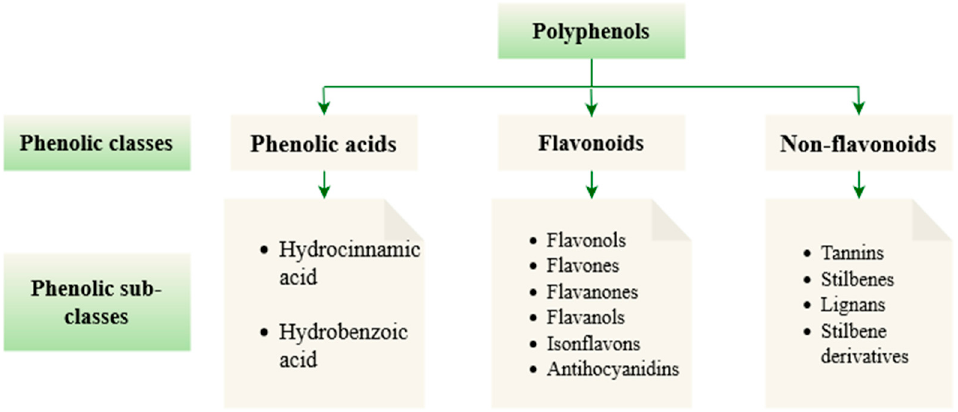
Figure 12. Phenolic classes and sub-classes.